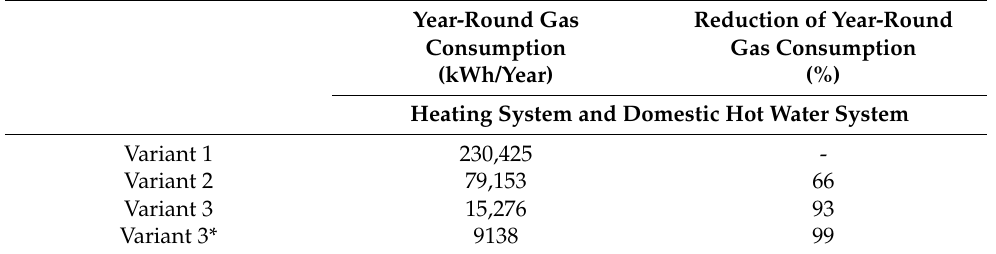
Table 3. Year-round gas consumption in the CEEE’s building for all calculation